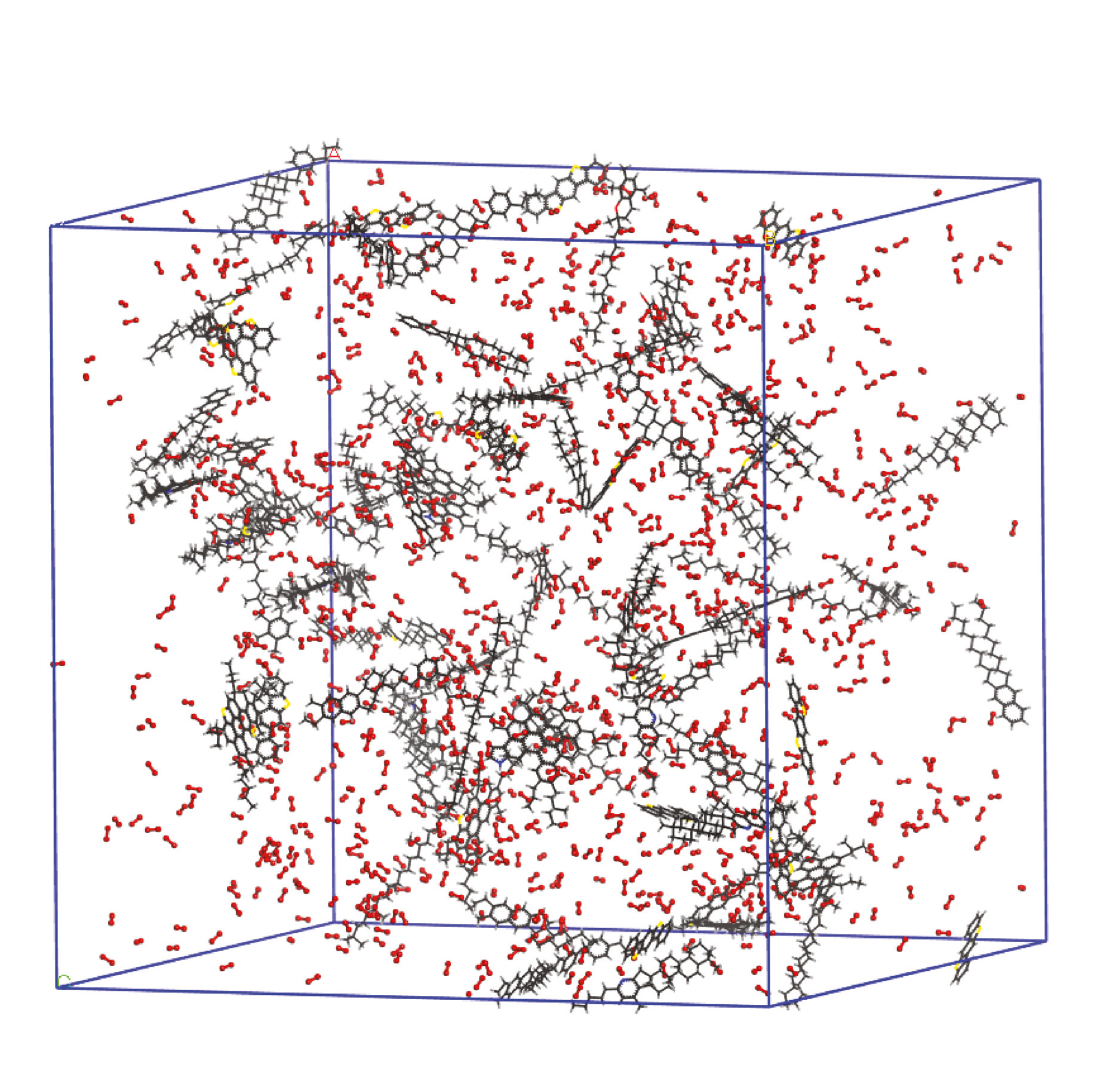
Figure 2: Reaction system of base asphalt for ReaxFF simulations (102.4 ˚A × 102.4 ˚A × 102.4 ˚A, black molecules are asphalt, red molecules are O 2